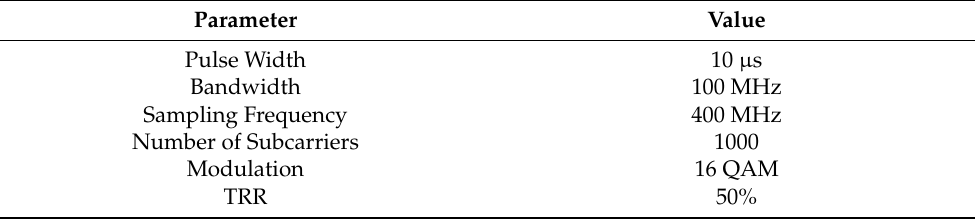
Table 1. Simulation